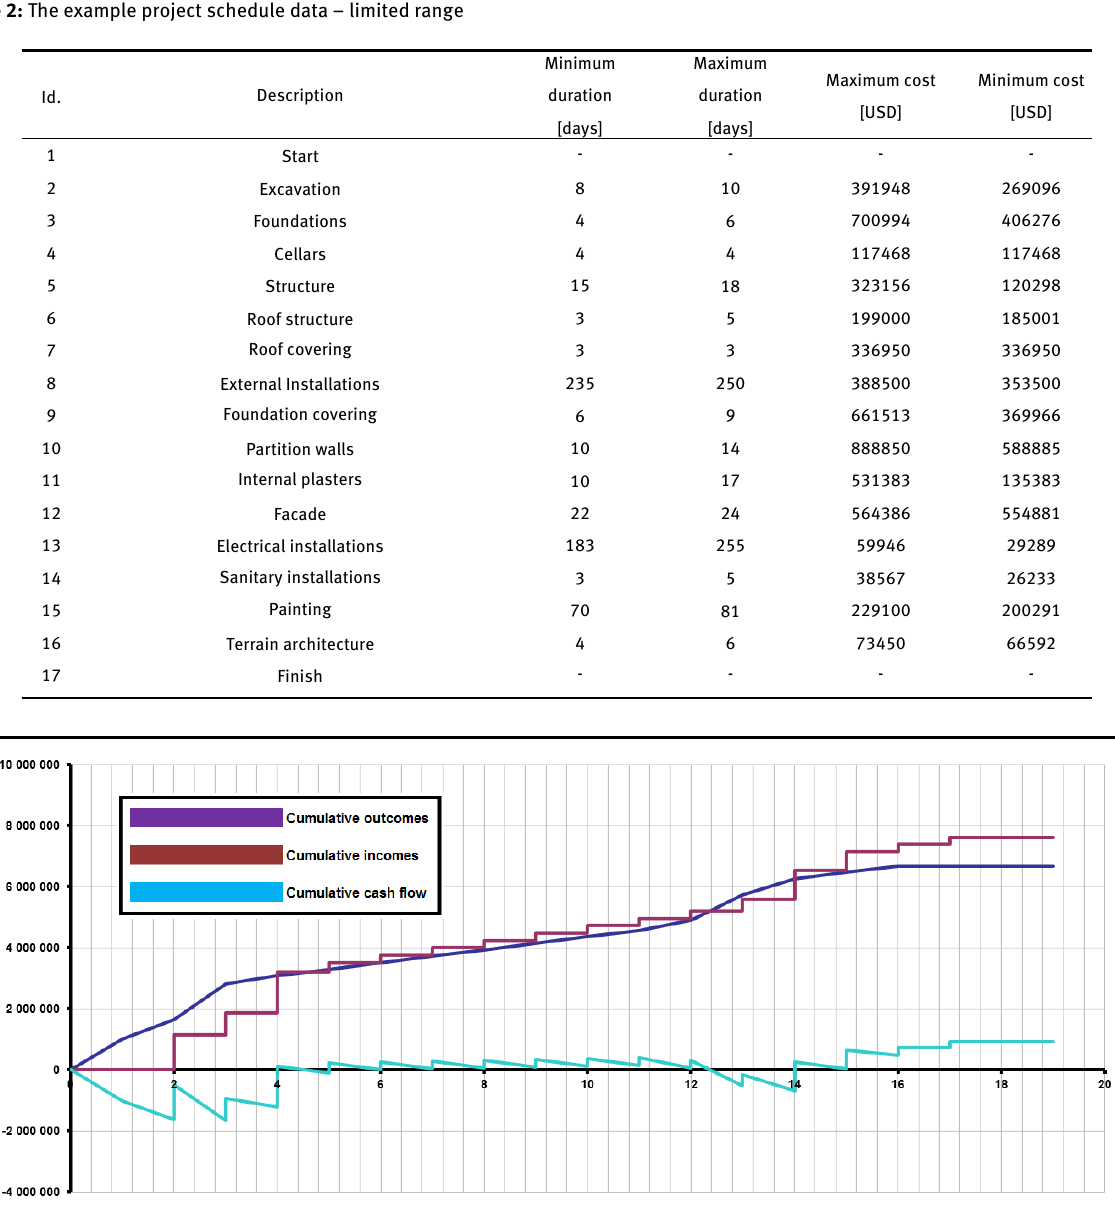
The cash flow for respective periods and project sched- ule for the best calculated case are presented in Figure 3 and